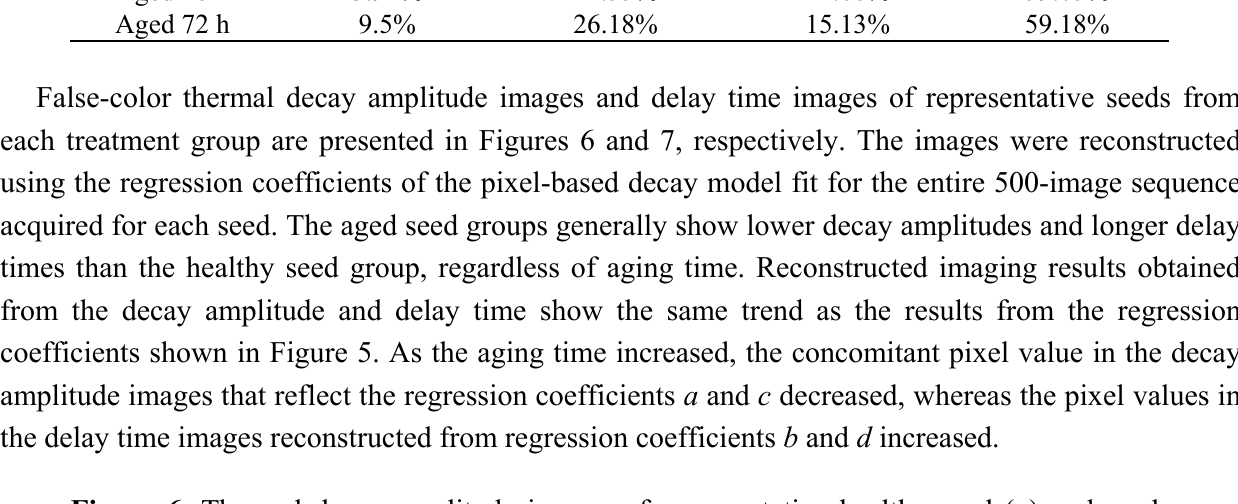
Figure 6. Thermal decay amplitude images of representative healthy seed ( a ) and seeds aged for 24 h ( b ), 48 h ( c ), and 72 h ( d ), produced using an exponential decay